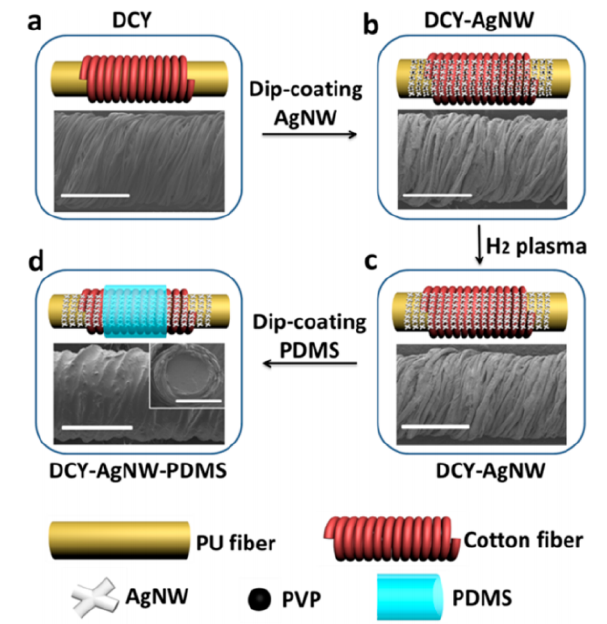
Figure 3. Schematic illustration of the fabrication process of the composite fiber. ( a ) Structural representation and SEM image of the DCY. For simplicity and clarity, only one CY was demonstrated in the structural drawing. ( b ) Structural representation and SEM image of DCY-AgNW before H 2 plasma treatment. ( c ) Structural representation and SEM image of DCY-AgNW after H 2 plasma treatment. ( d ) Structural representation and SEM images of DCY-AgNW-PDMS. The inset SEM image shows the cross-sectional structure. The PDMS infiltrated the whole CY layer. Scale bar for all images: 500 µ m. DCY, DCY-AgNW and DCY-AgNW-PDMS all have diameters of 650 µ m. Reprinted